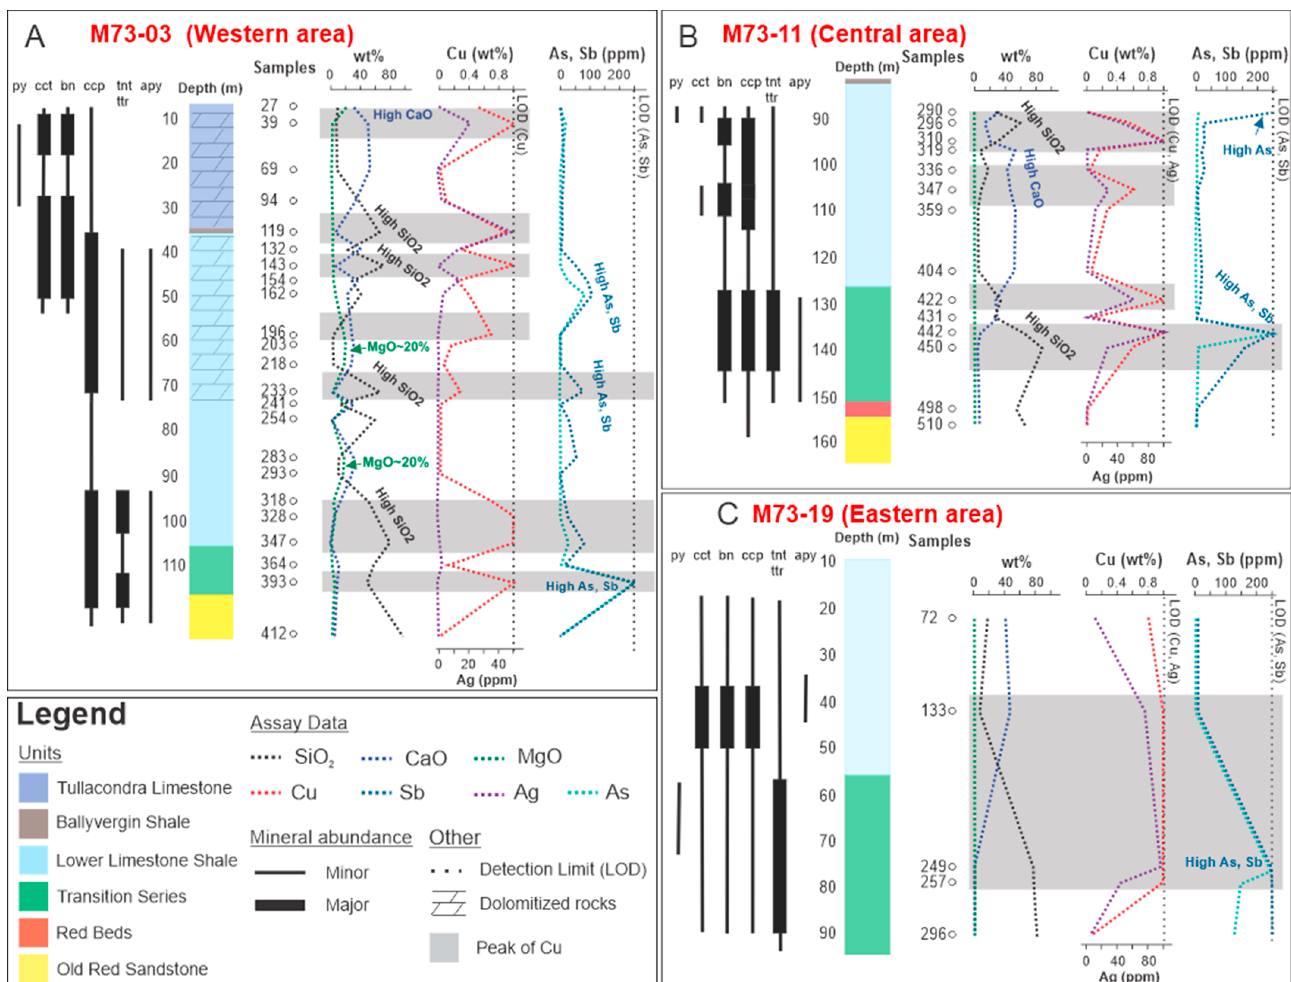
Figure 9. Assay data and mineral abundance from sampled drill cores from: ( A ) the western area, ( B ) the central area, and ( C ) the eastern area. Bore hole locations are depicted in Figures 4 and 5. Note the variation of the main ore minerals pyrite (py), chalcocite (cct), bornite (bn), chalcopyrite (ccp), tennantite (tnt), tetrahedrite (ttr), and arsenopyrite (apy), and of main elements (SiO 2 , CaO, and MgO) and ore-related metals (Cu, Ag, As, and Sb). Peaks of Cu content are highlighted/shaded in grey.